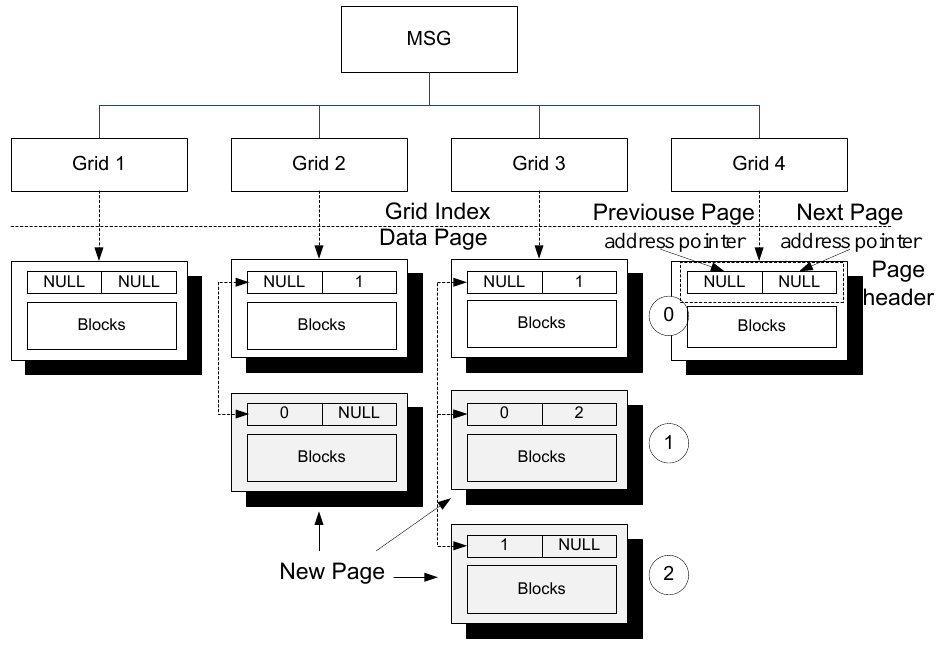
Figure 6. Incremental update mechanism in incremental data update method.